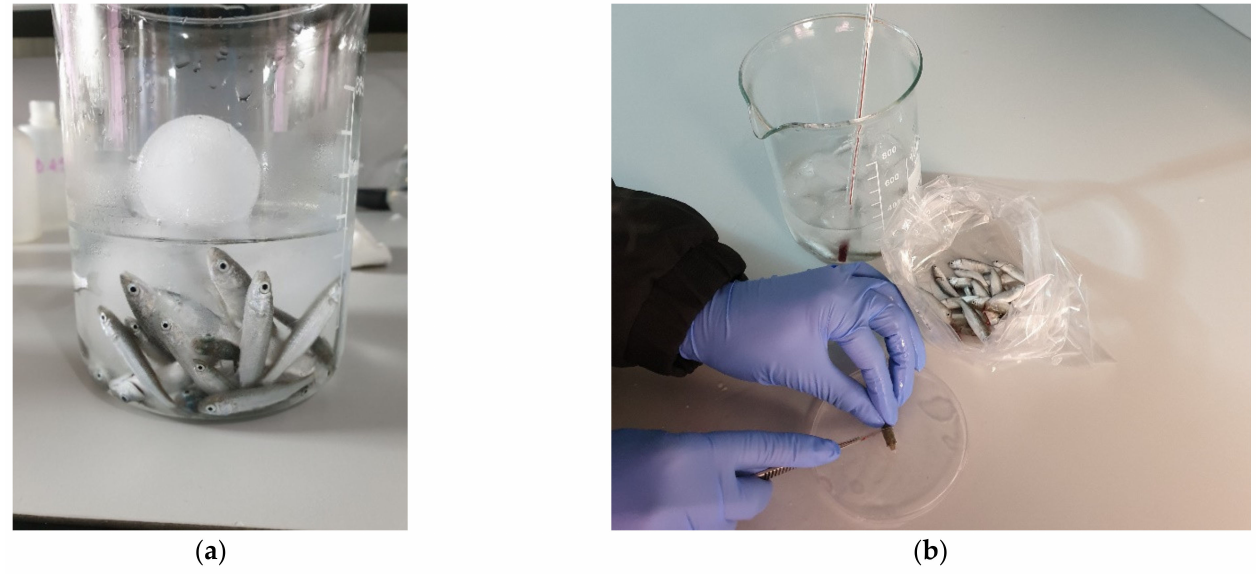
Figure 5. ( a ) Fish placed in ice slurry for euthanasia; ( b ) Sectioning the spinal cord (original